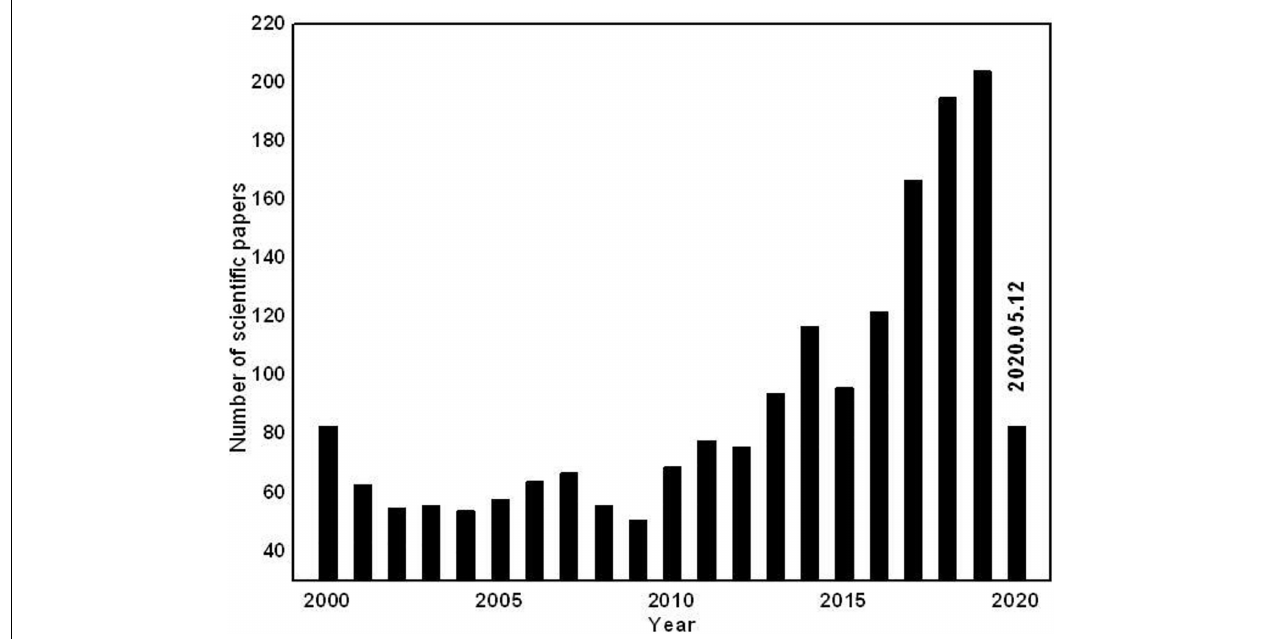
FIGURE 1 | Number of publications on electrode/electrolyte interface in LIBs according to Web of Science (accessed: May 12, 2020).